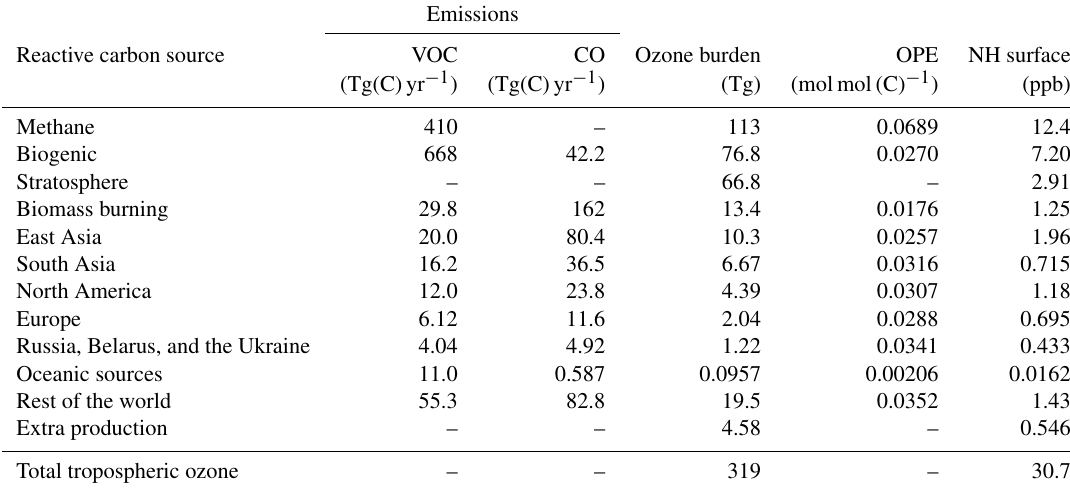
Table 3. The attribution of ozone to tagged sources of reactive carbon. Also shown are the contribution of the stratosphere and the contribution of minor chemical production pathways in the troposphere. Contributions of each tagged source to both the 2010 annual average tropospheric burden and to the annual average Northern Hemisphere (NH) surface mixing ratio are shown. Where applicable, the ozone production efficiency (OPE) of reactive carbon emissions from each tagged source is also